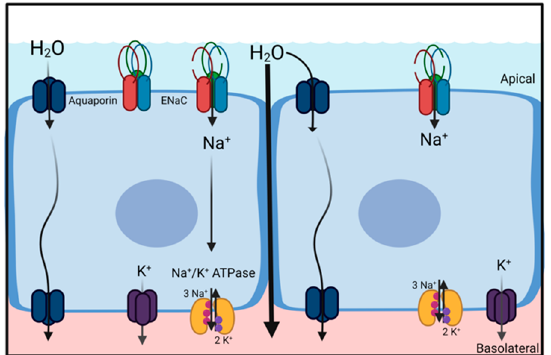
Figure 2. Principal mechanism for Na + driven water absorption in absorptive epithelia, including alveolar and airway epithelia. Na + absorption is facilitated by the basolateral Na + /K + -ATPase that maintains an electrochemical gradient, for Na + to enter the cells via an apical channel such as ENaC. This process generates an osmotic gradient across the epithelium that causes water molecules to follow. Water moves either through the transcellular (aquaporins) or paracellular pathway (created with BioRender.com).